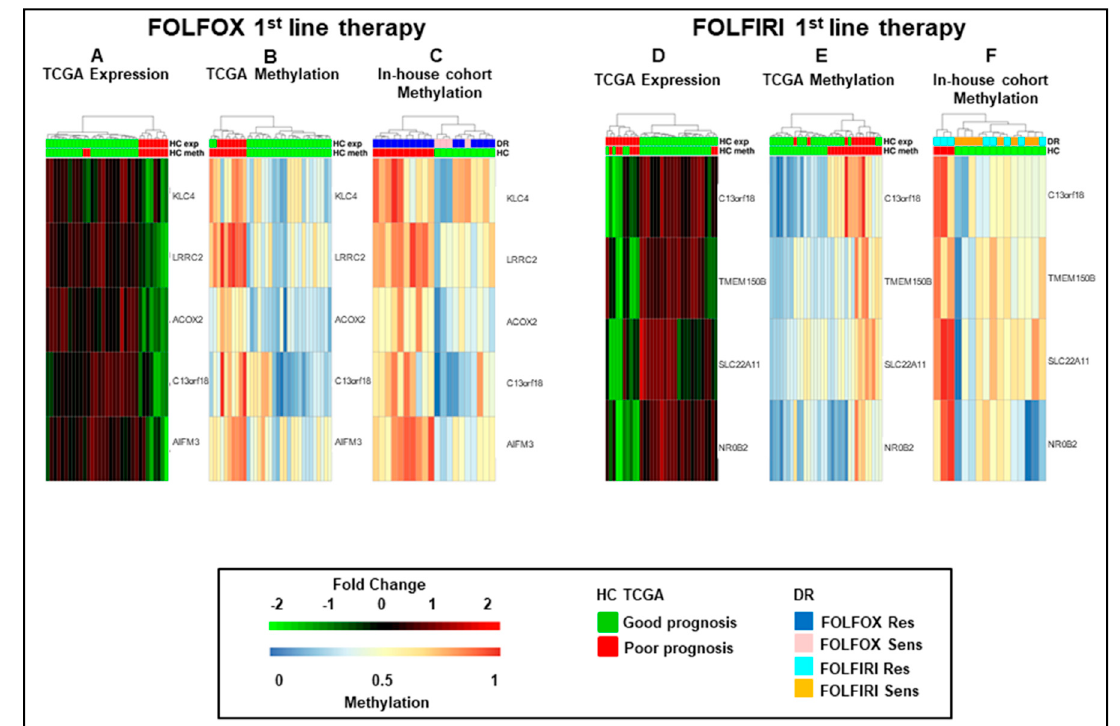
Figure 2. Hierarchical clustering of mCRCs according to the five and four-gene signatures. ( A – F ). Heatmaps of functionally methylated genes in The Cancer Genome Atlas COlon ADenocarcinoma (TCGA COAD) dataset ( A , B , D , E ) and in in-house first-line FOLFOX ( C ) or FOLFIRI ( F ) datasets. ( A ) and ( D ). Differential gene expression profiles in TCGA COAD. ( B ) and ( E ). Differential methylation profiles in TCGA COAD dataset. ( C ) and ( F ). Differential methylation profiles in in-house FOLFOX or FOLFIRI cohorts. HC, hierarchical clustering; DR, drug response.